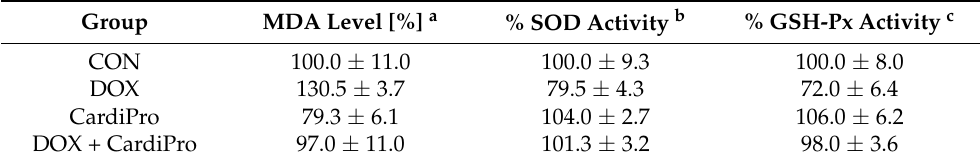
Table 11. Effect of CardiPro on lipid peroxidation and the level of antioxidant enzymes in the heart tissue of DOX-treated mice (cumulative dose 16 mg/kg) [85].